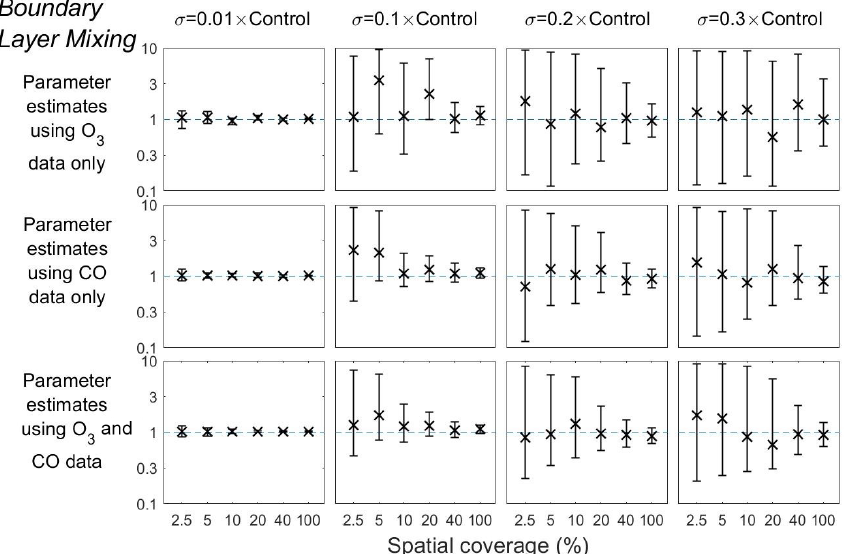
Figure 9. Means and 95% credible intervals of 3000 samples of the Boundary layer mixing scaling parameter from posterior distributions using the MCMC algorithm based on synthetic datasets from scenarios 1–72 (Table 1). Control refers to the FRSGC/UCI model control run surface concentration at each output point. The scaling parameter values are given here on a log 10